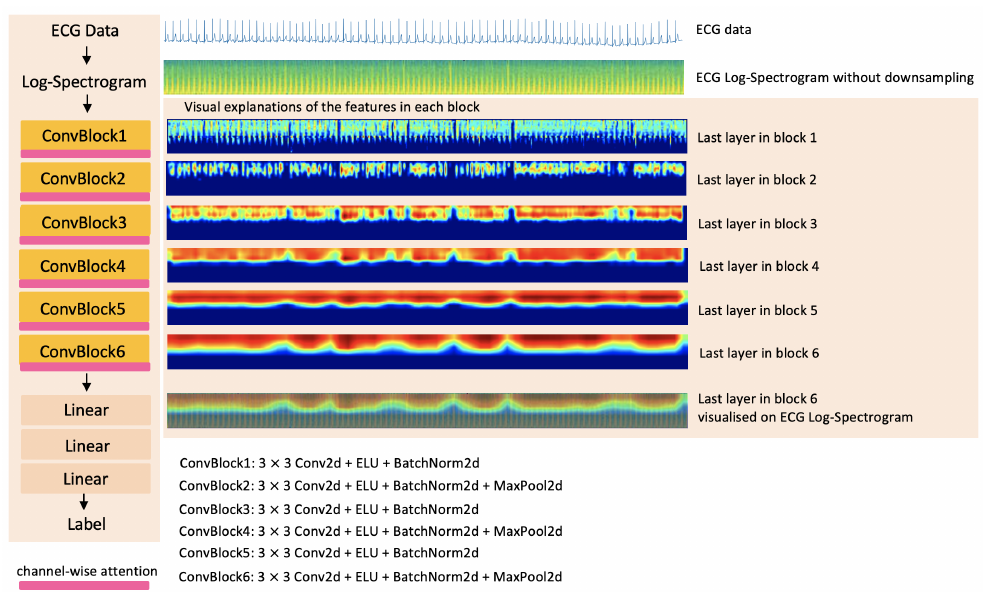
Figure 1. Overview of the proposed method and the visual explanations of features for the label 0-mild tetanus in the last layers of 6 convolutional blocks of the method. The 60-s window length log-spectrogram of raw ECG data is the input of the proposed method called 2D-CNN + Channel-wise Attention. The output of the proposed method is the label prediction, label 0 (mild tetanus) and label 1 (severe